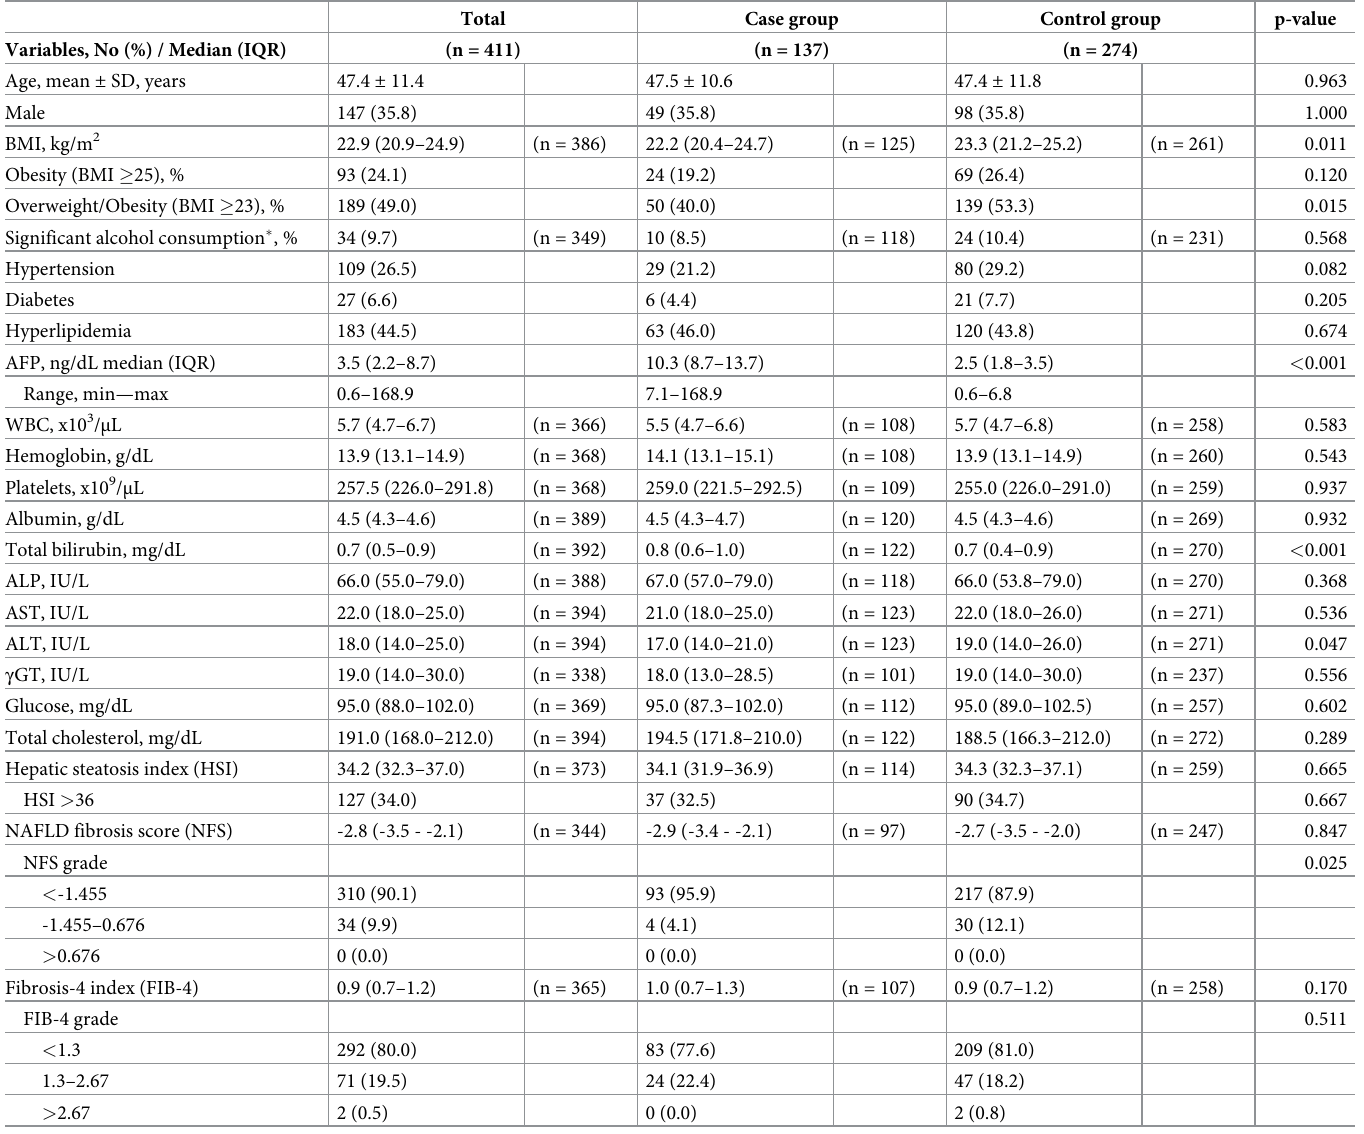
Table 1. Baseline characteristics of the case group with elevated AFP in comparison with the control